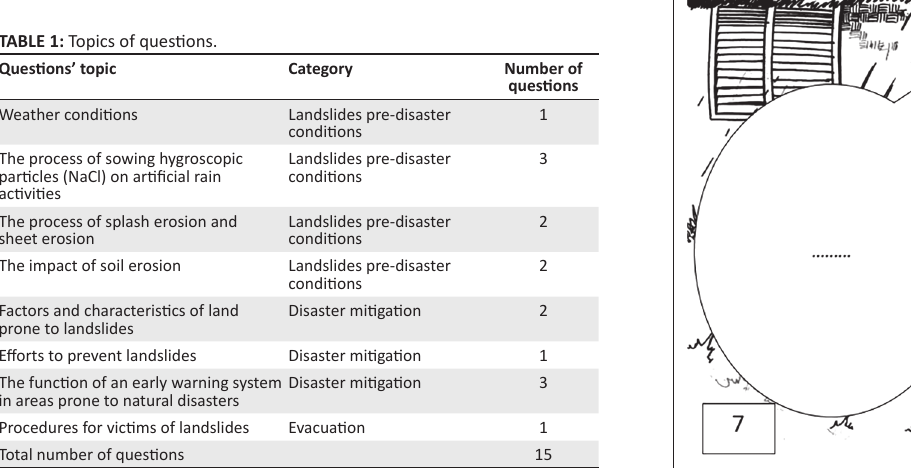
FIGURE 4 : Sample of question in comic worksheets.